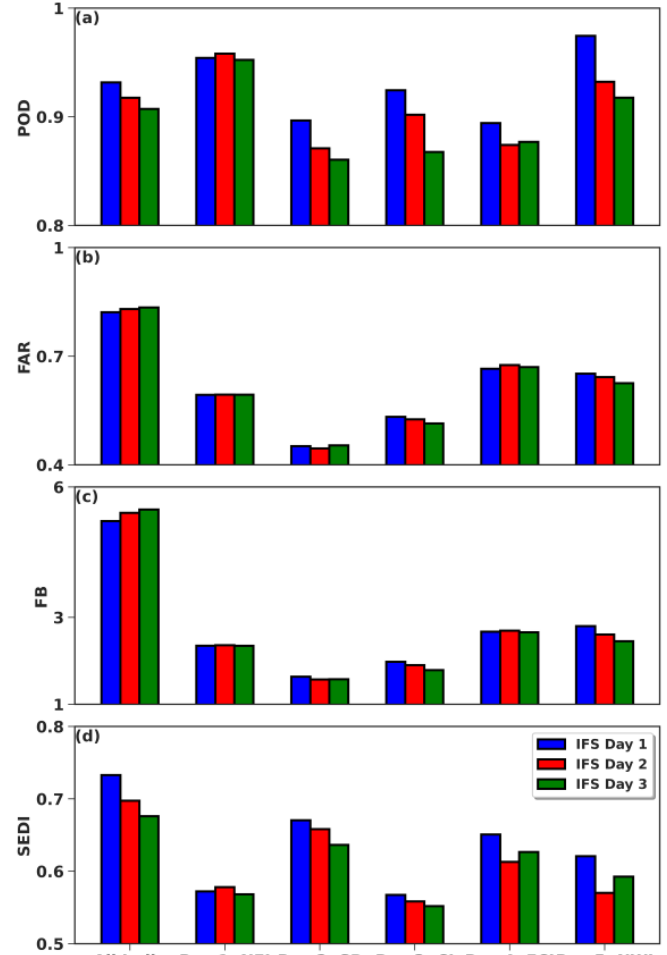
Figure 8. Forecast Skills—( a ) probability of detection (POD), ( b ) false alarm ratio (FAR), ( c ) Frequency Bias (FB), and ( d ) Symmetric Extremal Dependence Index (SEDI) for Yes/No forecast over all India and five thunderstorm-prone regions for Day 1 (blue), Day 2 (red) and Day 3 (green) lead time.